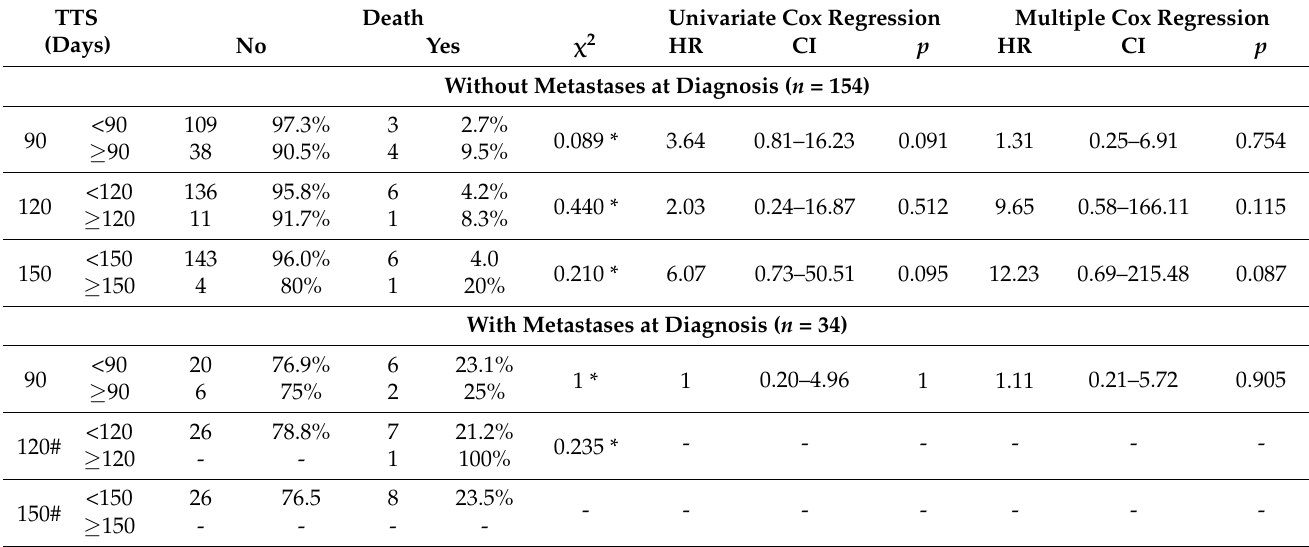
Table 4. Results of univariate und multivariate regression analysis of the impact of TTS on OS at different time points for patients with bilateral WT with and without metastases at